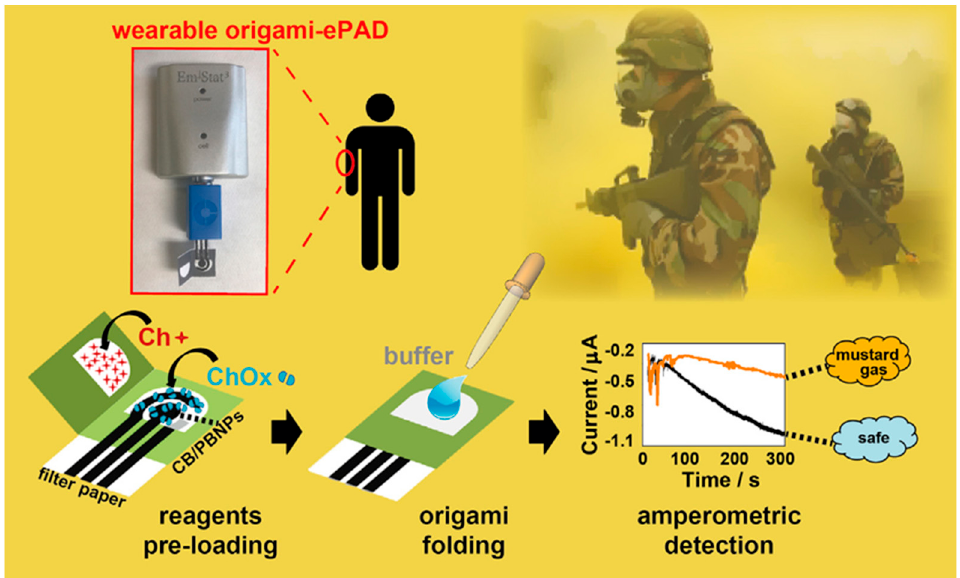
Figure 13. Working principle of the developed wearable mustard gas sensor [106]. Copyright: Elsevier B.V.